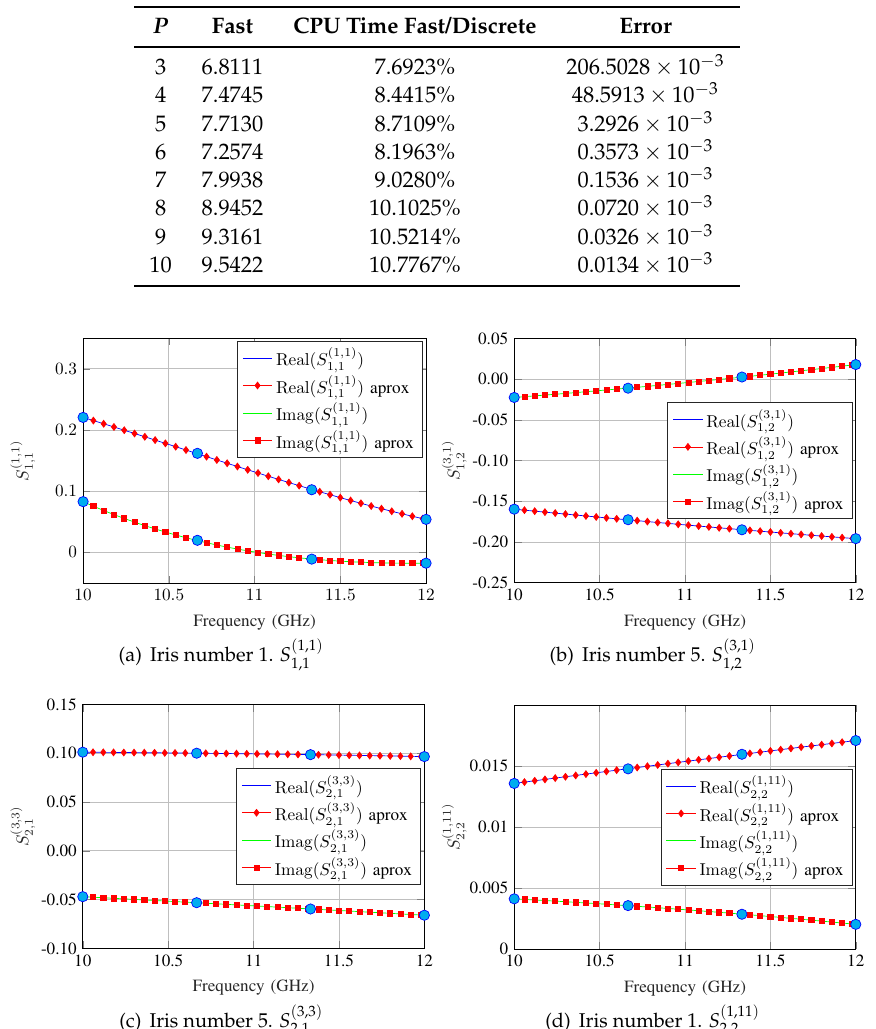
Figure 14. Comparison between accurate and approximate scattering parameters of different blocks of the SIW coupled cavities filter, and different combinations of input and output ports and modes. Big dots show the points used for spline approximation. In this case, using four points was enough for high accuracy results.